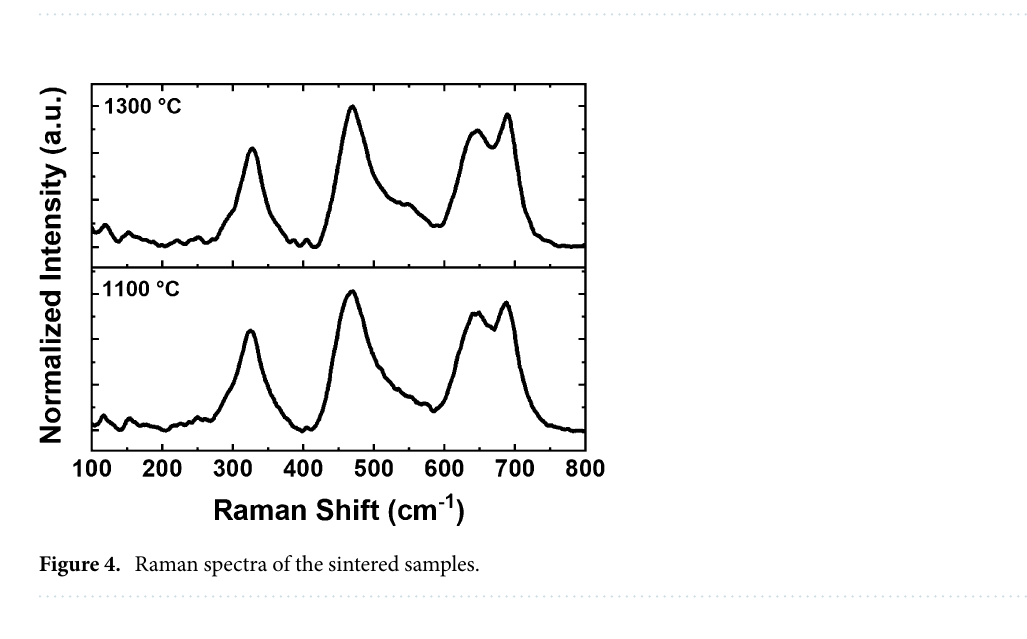
Table 1. The lattice parameter, theoretical density (ρ XRD ), cation distribution, strain (ε), and dislocation density (δ).